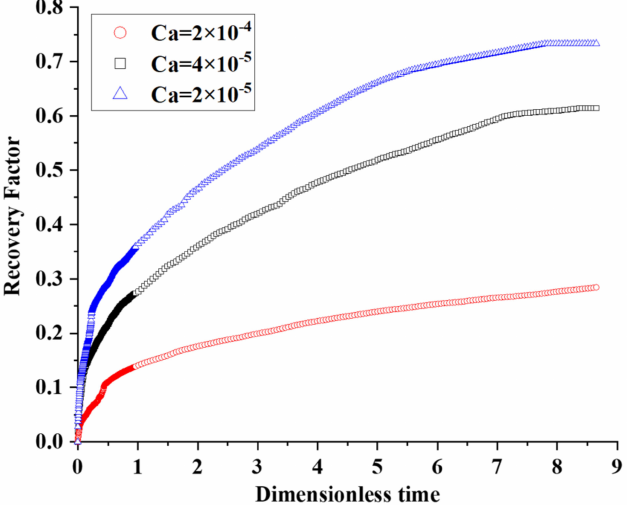
Figure 18. Recovery factor with different oil-water interfacial